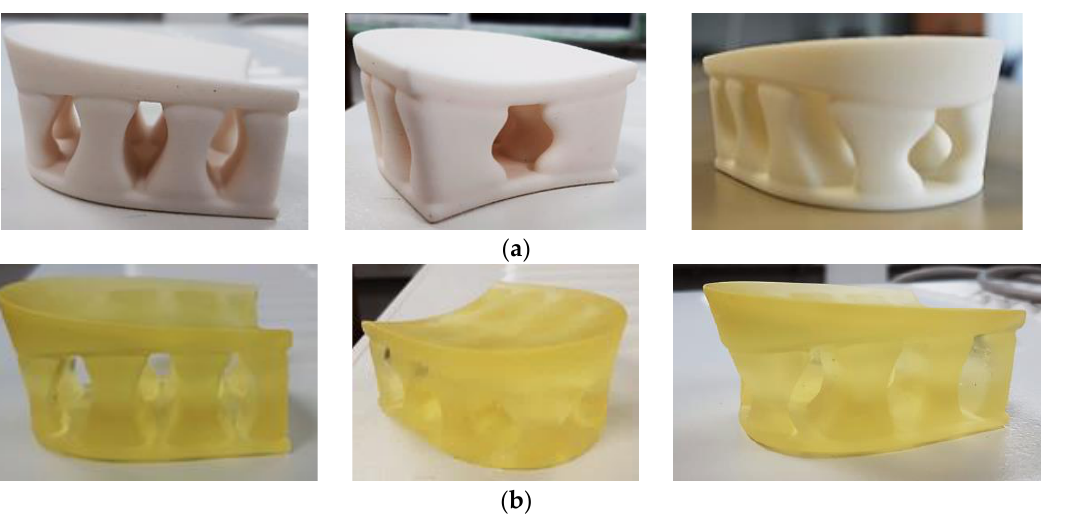
Figure 9. The samples of heel prototypes after compression test: ( a ) heels printed by the SLS method from PA12; ( b ) heels printed from photopolymer by the SLA method.